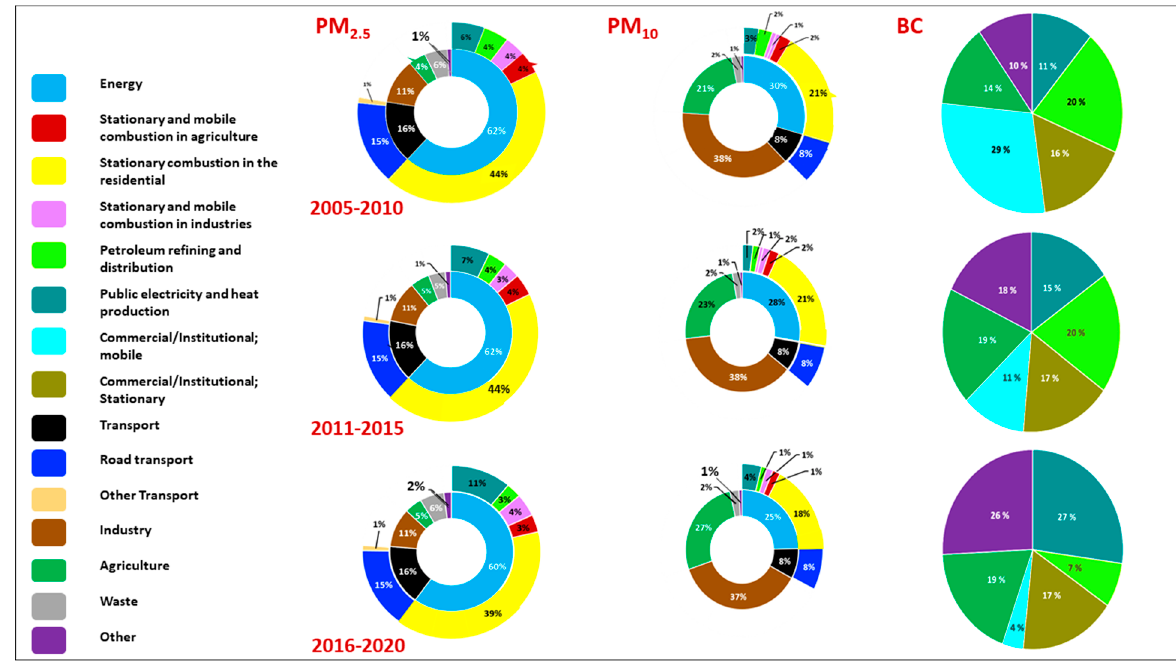
Figure 5. PMs’ national emissions for Lithuania from different sectors 2005–2020.